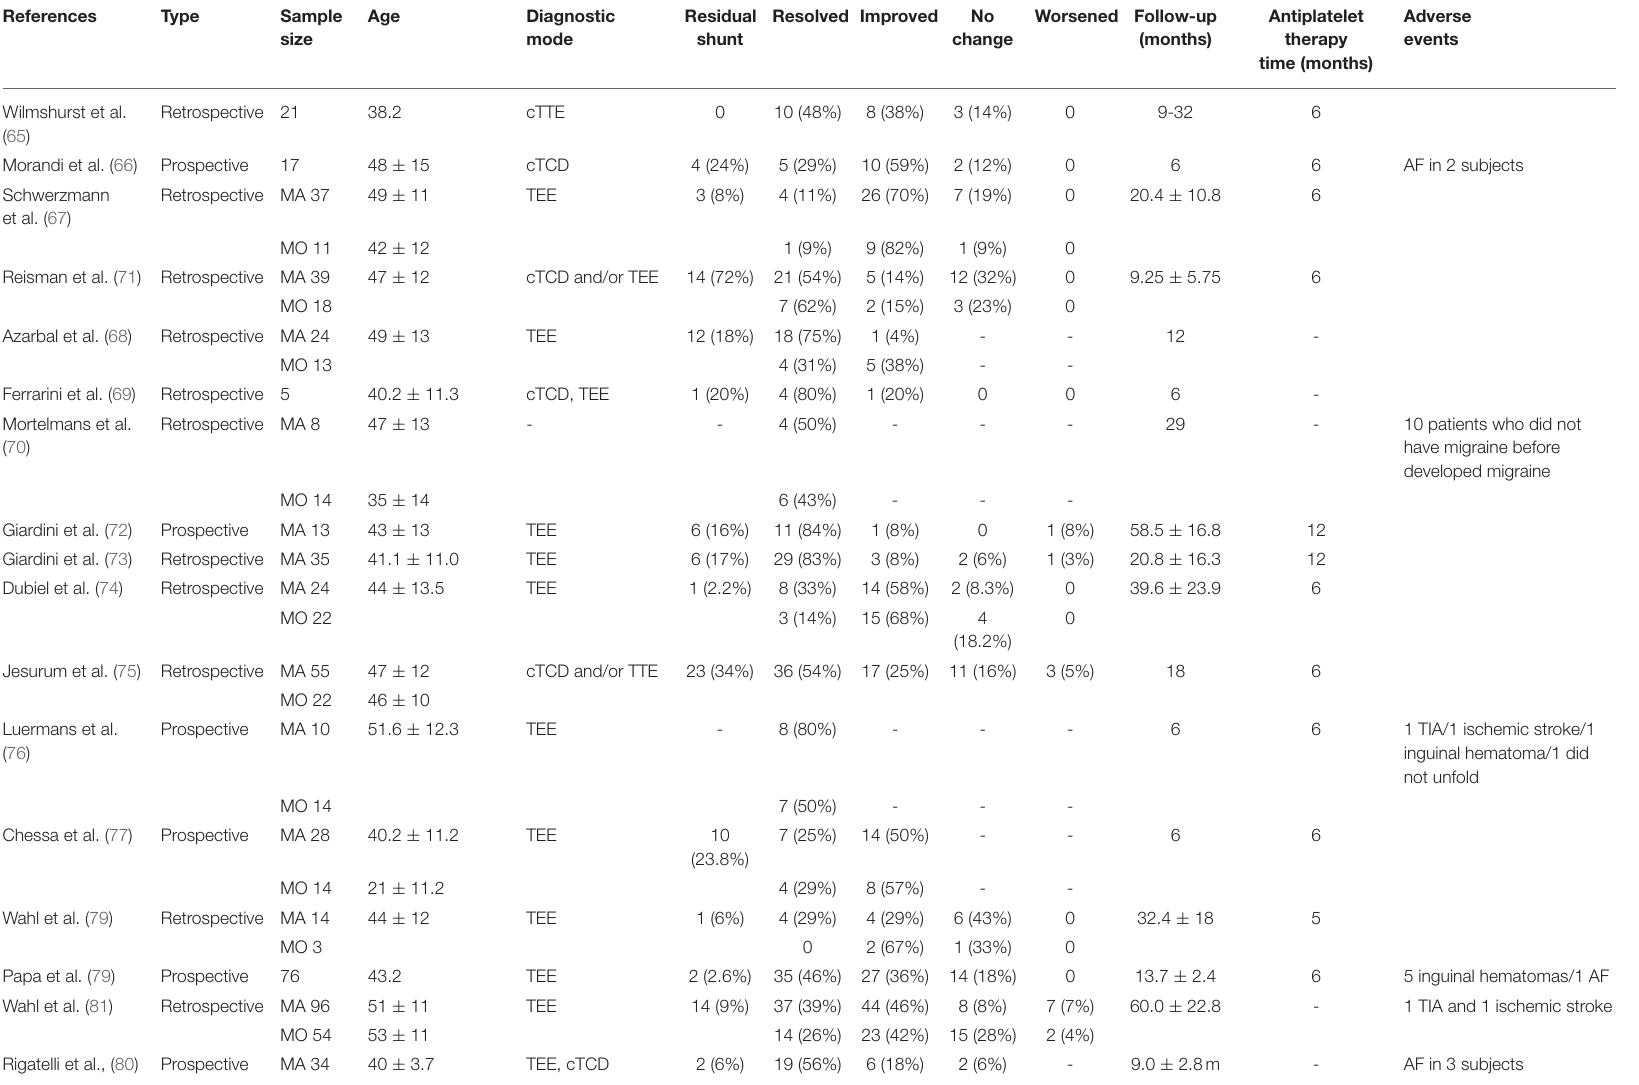
TABLE 1 | The Effect of Patent Foramen Ovale Closure on Migraine in case series